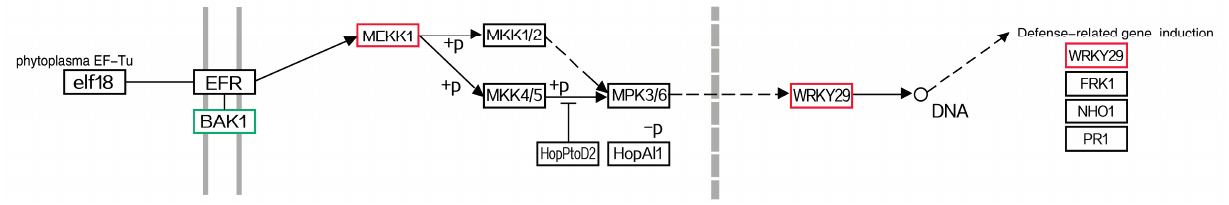
Figure 8. Elongation factor Tu (EF-Tu) response pathway in P. fortunei . Genes in boxes are differently expressed. Red boxes indicate up-regulated or induced genes in the infected seedlings. Green boxes indicate down-regulated